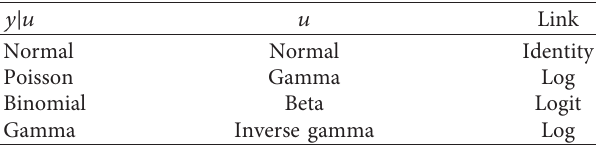
Table 1: Conjugate